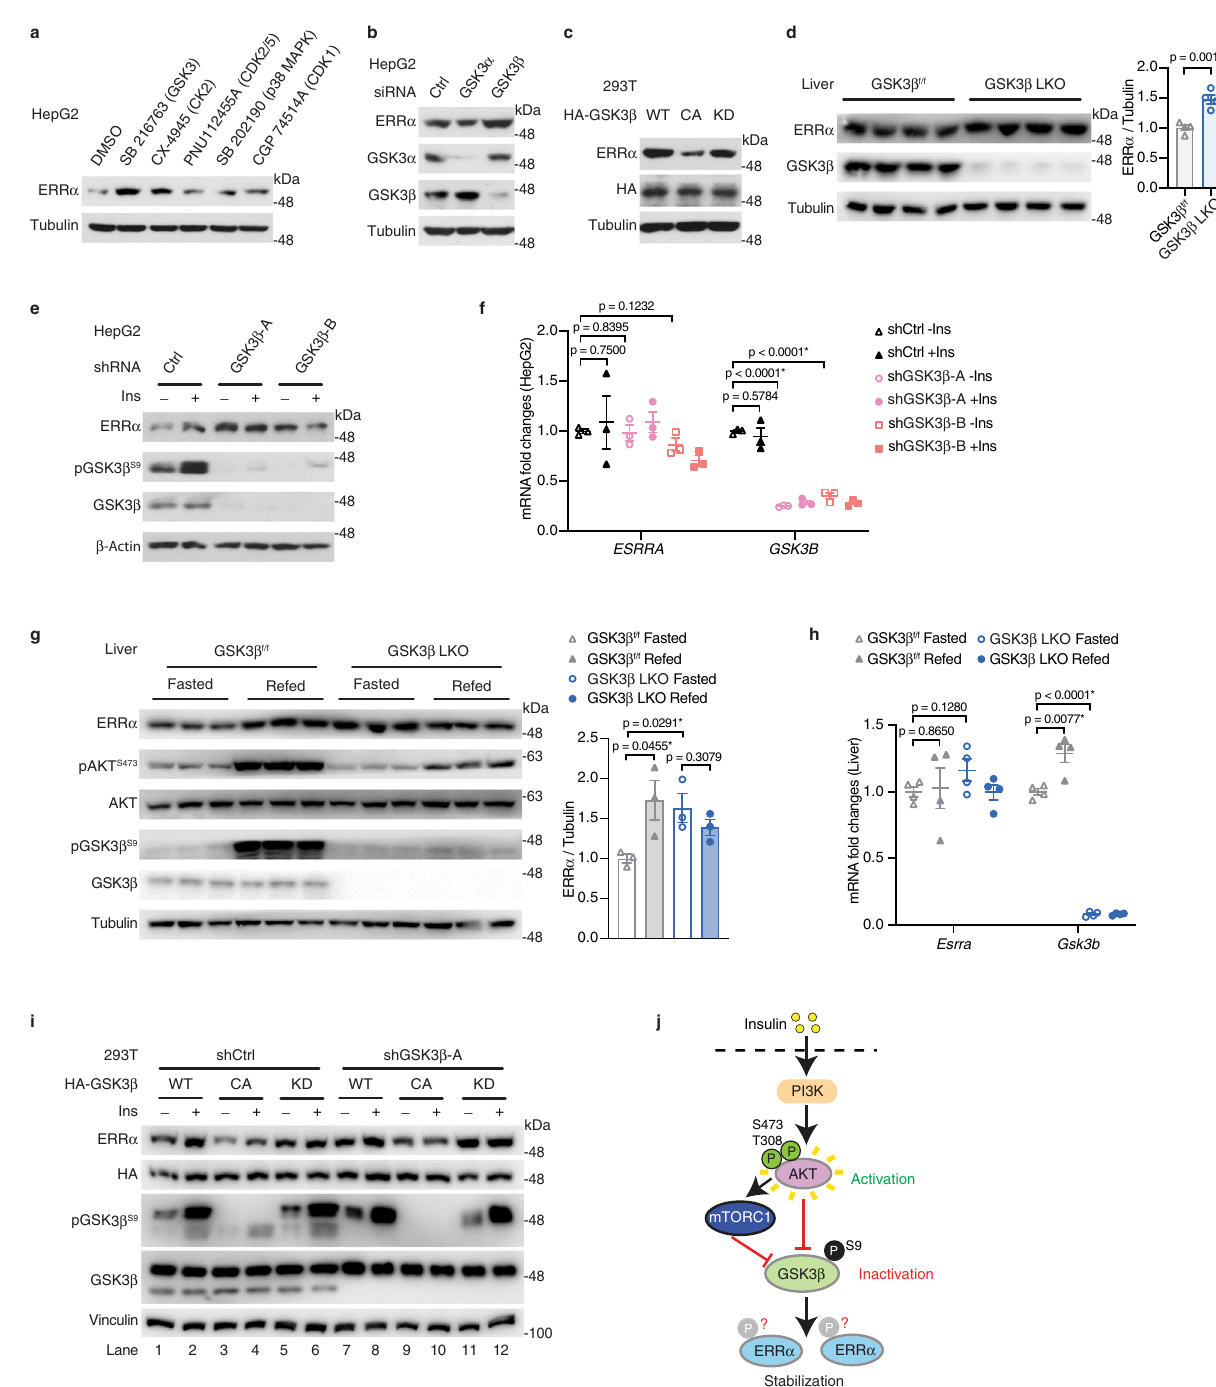
Fig. 2 GSK3 β is required for the control of ERR α stability by insulin. a ERR α protein levels in HepG2 cells treated with either DMSO control or 10 μ M of kinase speci fi c-inhibitors SB 216763, CX-4945, PNU112455A, SB 202190 or CGP 74514A for 4 h. b ERR α protein levels in HepG2 cells transfected with 20 nM of either control, GSK3 α or GSK3 β siRNA for 72 h. c ERR α protein levels in 293T cells transfected with vectors expressing HA-GSK3 β WT, constitutively active S9A mutant (CA), or kinase defective K85A mutant (KD) for 48 h. d Immunoblots (left, each lane represents liver from one mouse, n = 4 per group) and quanti fi cation (right) of ERR α protein levels in livers from GSK3 β f/f and GSK3 β LKO mice. e ERR α protein levels and f mRNA levels of ESRRA and GSK3B ( n = 3 per group) in HepG2 cells stably expressing either control shRNA or 2 distinct shRNAs targeting GSK3 β . Cells were treated with 10 μ g/ml insulin for 30 min after overnight serum starvation. g Western blots (left, each lane represents liver from one mouse, n = 3 per group) and quanti fi cation (right) of ERR α protein levels in livers from GSK3 β LKO and their fl oxed littermates upon a fasting-refeeding transition. h Esrra and Gsk3b mRNA levels in control and GSK3 β -null livers upon a fasting-refeeding transition ( n = 4 per group). i 293T cells stably expressing either control or shRNA targeting GSK3 β were transfected with HA-GSK3 β WT, CA, or KD vectors for 48 h, cells were treated with 10 μ g/ml insulin for 30 min after overnight serum starvation. j Proposed model of insulin-mediated stabilization of ERR α protein through the PI3K/AKT/ GSK3 β pathway. Data are presented as means ± SEM, * p < 0.05, unpaired two-tailed Student ’ s t test ( d , f – h ). Source data are provided as a Source Data fi